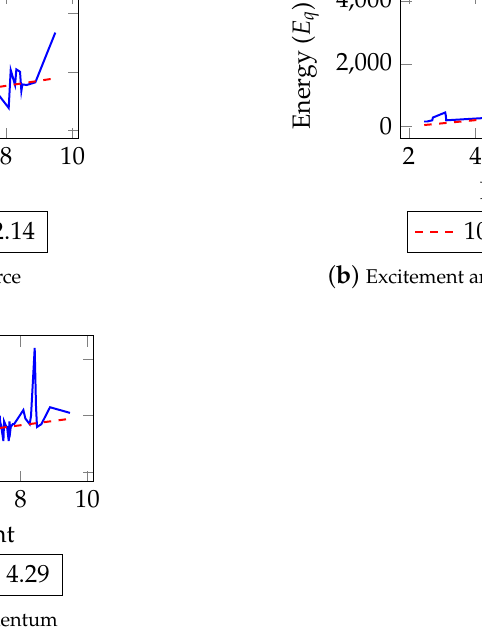
Figure 2. The dynamics of computed physical roller coaster based on increasing excitement and ( a ) Force, ( b ) Energy, and ( c )